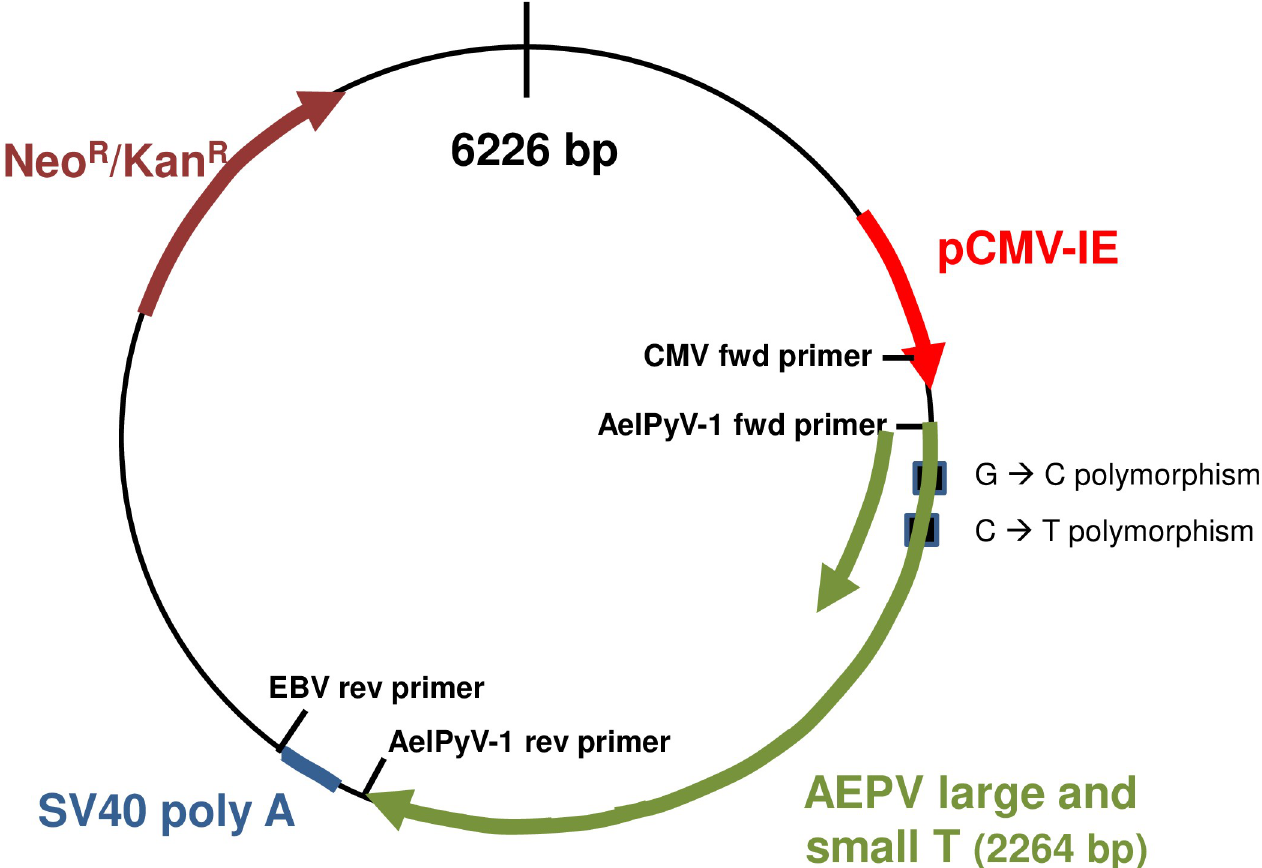
Fig 3. Cloning strategy. The T antigen-encoding region was amplified from elephant BW1 MaleNOD1, then inserted into the plasmid pEGFP-N1 (accession #U55762). DH5A competent bacteria were transformed and grown on kanamycin-resistant LB and amplified in a PCR reaction. PCR products were analyzed for expected band size of 2265 bp. Appropriate size gel bands were sequenced with standard primers (CMV forward and SV40 reverse to verify the presence and integrity of the AeIPyV-1 early region